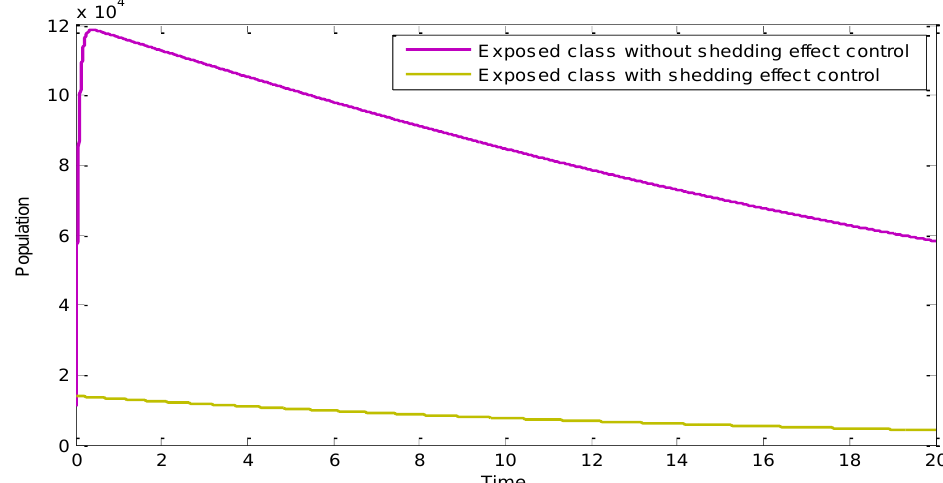
Figure 3. Dynamics of susceptible population with control.